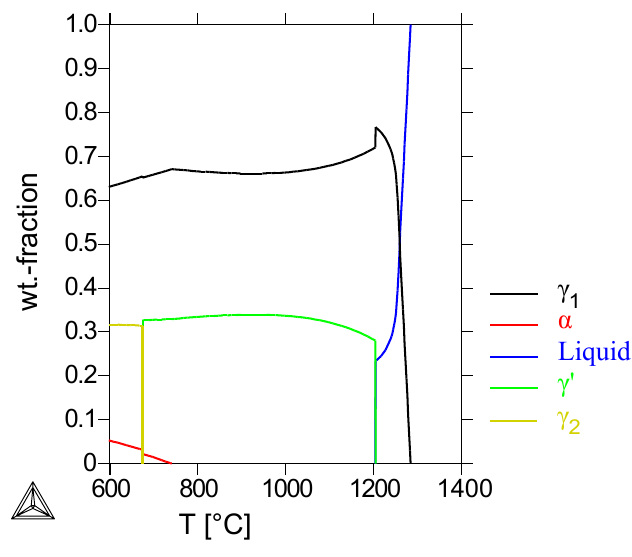
Figure 8. Thermo-Calc calculations for the alloy Ni-30%Cu-22%Cr.